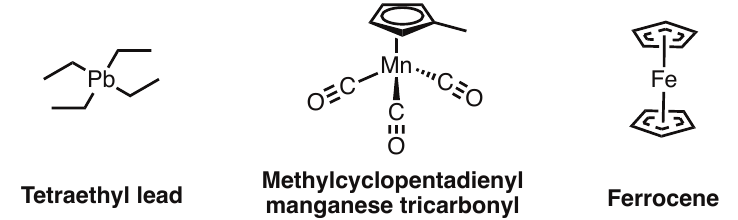
Figure 1. Chemical structures of the metallic anti-knock additives: tetraethyl lead (TEL), methylcyclopentadienyl manganese tricarbonyl, and